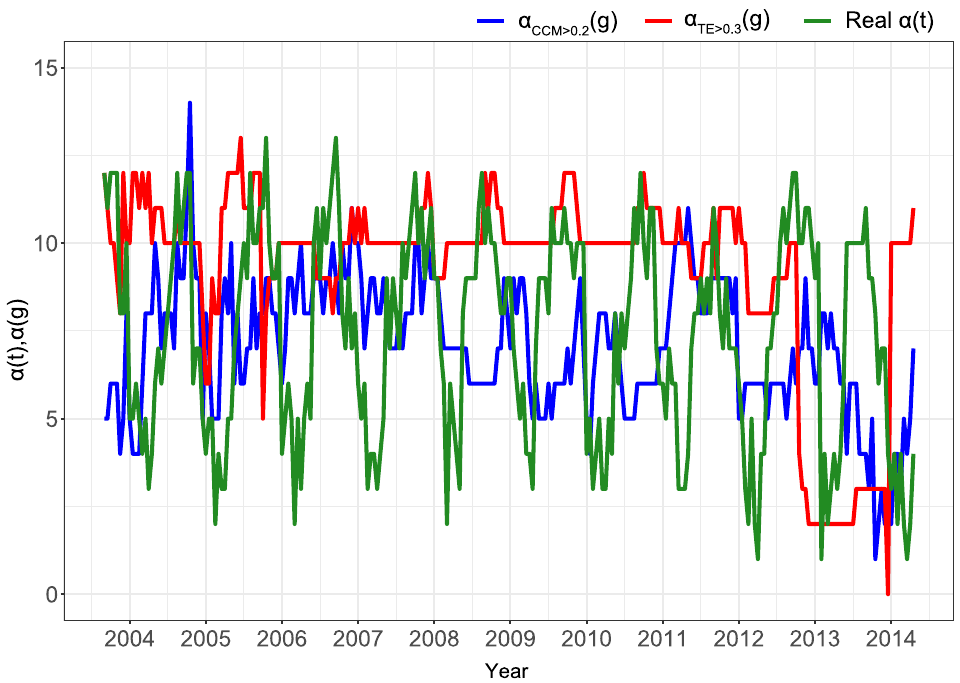
Figure 8. Predicted α -diversity via optimal interaction threshold for CCM’s ρ and OIF’s TE versus taxonomic diversity. Effective α -diversity from CCM and OIF are shown (blue and red) for an optimal threshold of ρ and TE (i.e., 0.2 and 0.3) that maximizes the correlation coefficient and mutual information (MI) between